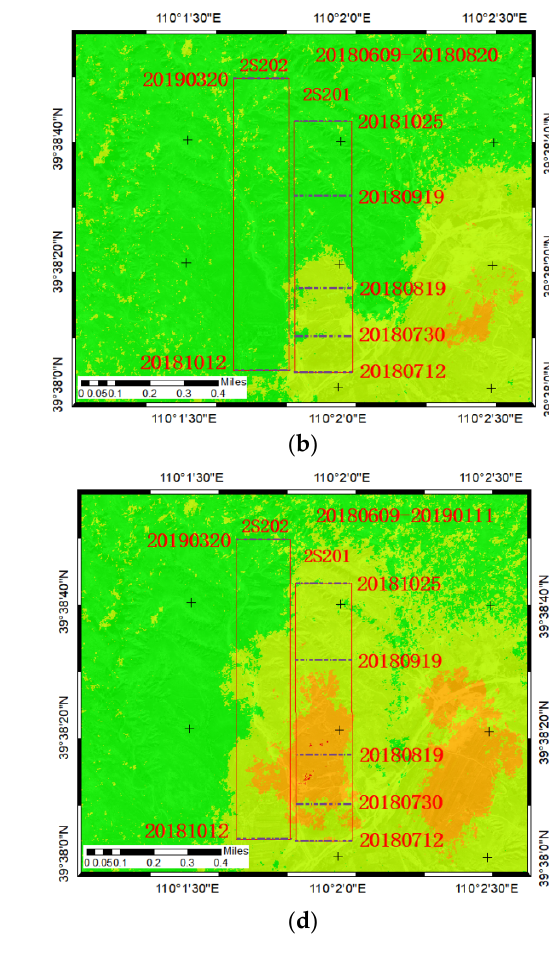
Figure 9. ( a – h ) are respectively the settlement maps of DInSAR.